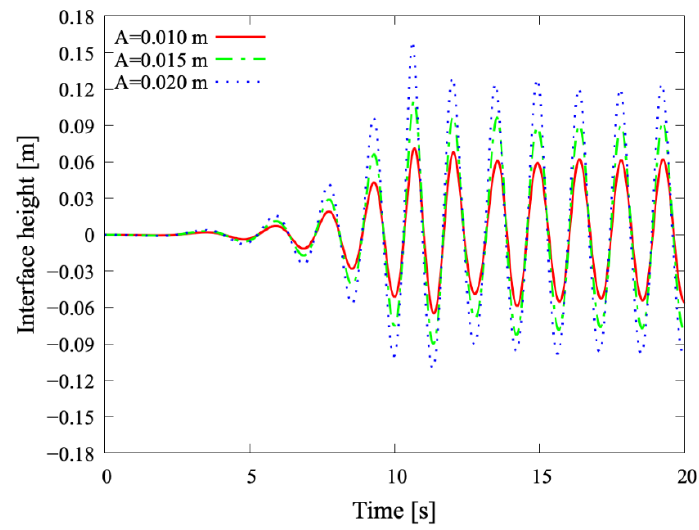
Figure 10. Time history of rogue wave’s elevation at focal point.